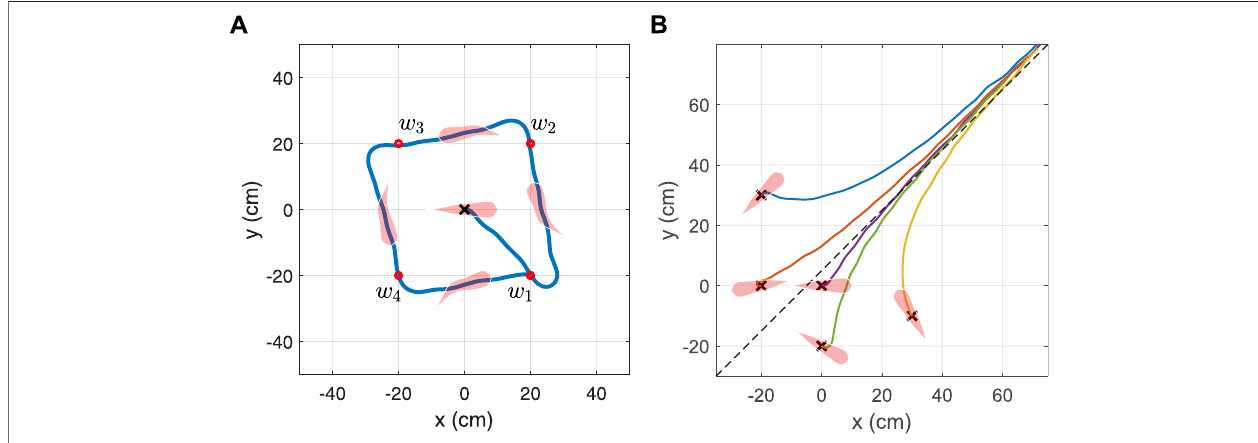
FIGURE 10 | Simulated result of the robotic fi sh following a path de fi ned by (A) a cyclic set of four waypoints and (B) a line de fi ned by the equation − x i + y i (cid:1) 5.